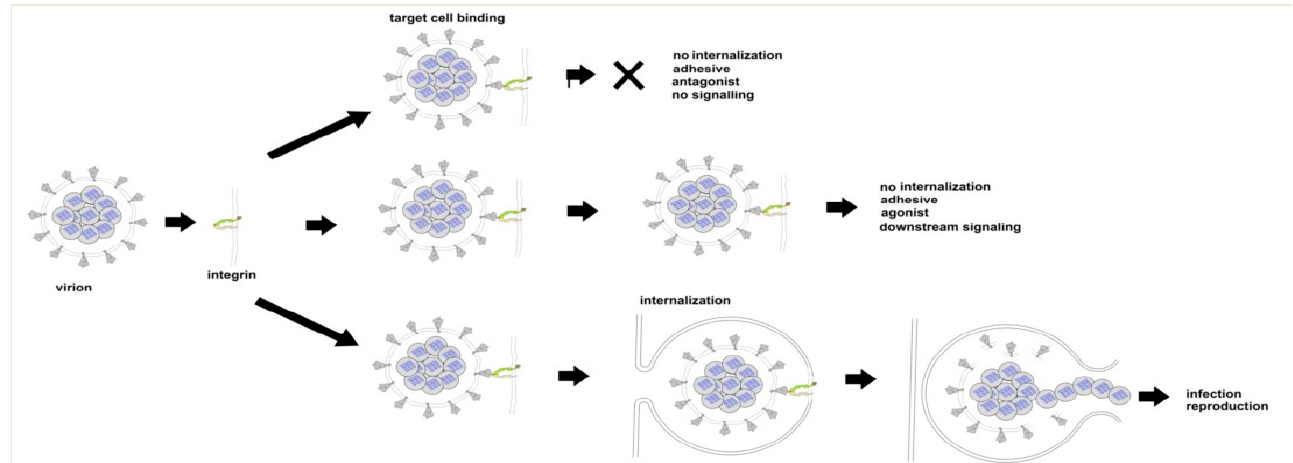
Figure 6. Three modes of viral interaction with cell surface integrins. Top: Binding without internalization or the triggering of integrin-mediated pathways (virion acting as antagonist). Middle: Binding without internalization but with the triggering of integrin-mediated pathways (virion acting as agonist). Bottom: viral internalization leading to infection and viral replication.